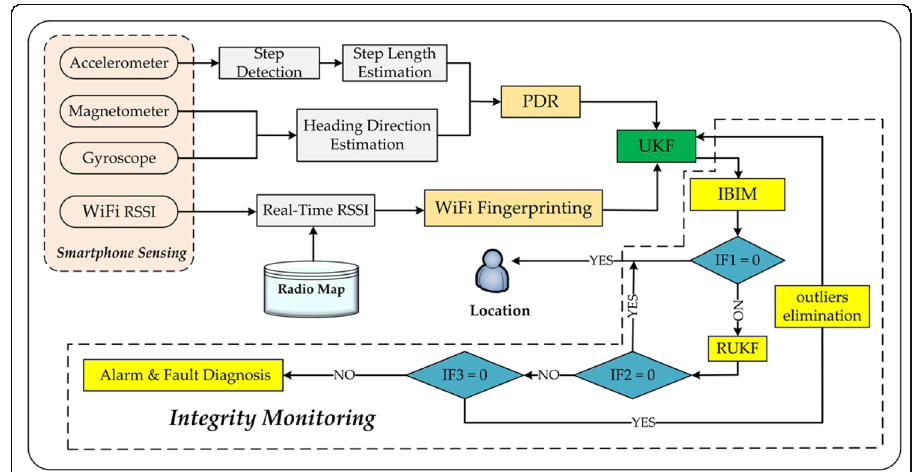
Fig. 1 Technical charts of the integrated positioning approach and integrity